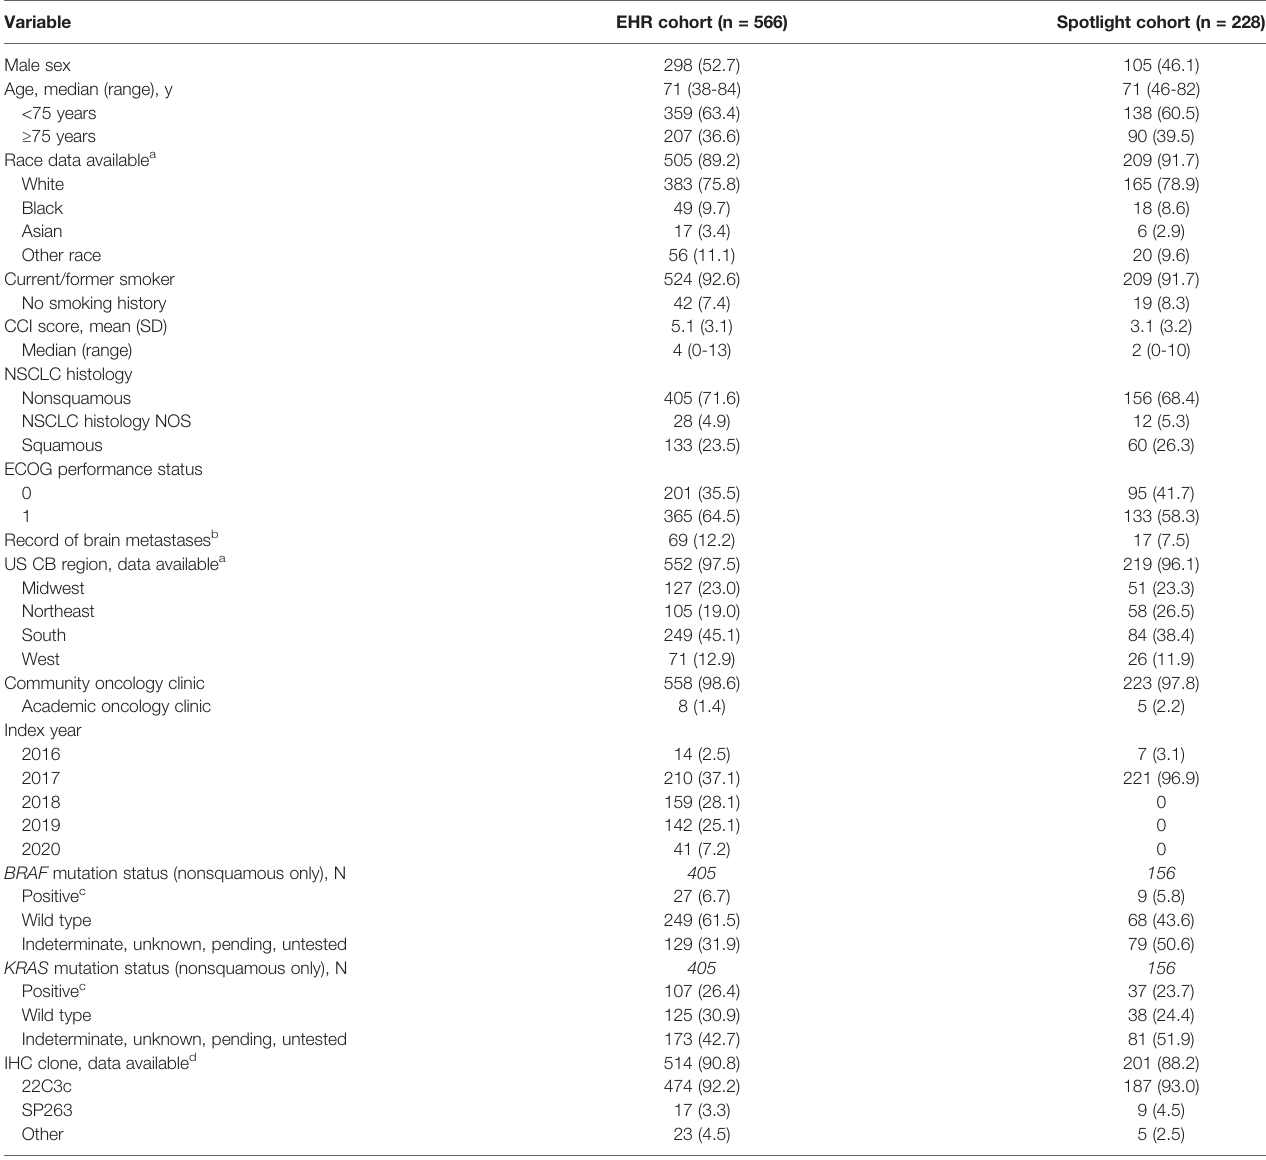
TABLE 1 | Baseline demographic and clinical characteristics of patients with stage IV NSCLC, PD-L1 expression ≥ 50%.